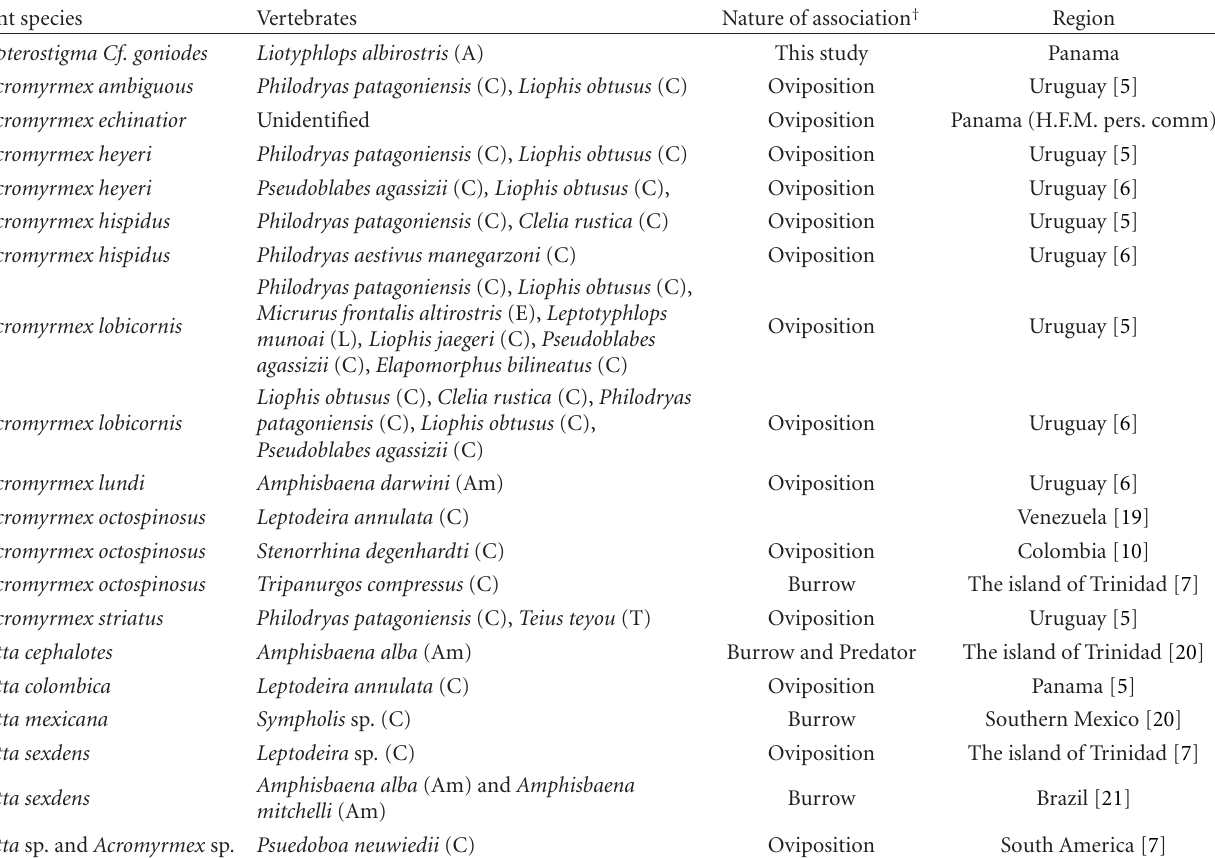
Table 2: General summary of Squamata associated with fungus-growing